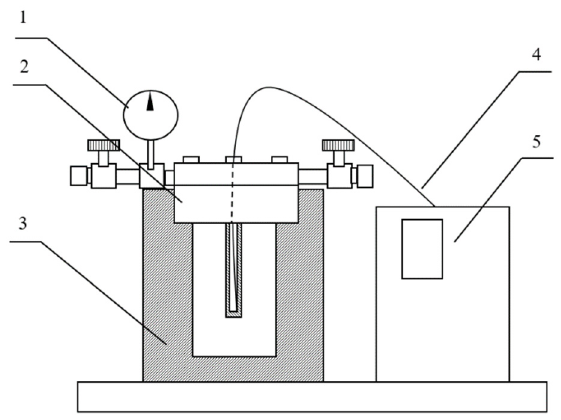
Figure 1. Schematic diagram of a hydrothermal reactor. 1 = pressure gauge; 2 = reactor body; 3 = heater; 4 = thermocouple; 5 = control unit. Table 1. Experimental conditions for HTG (group 1).